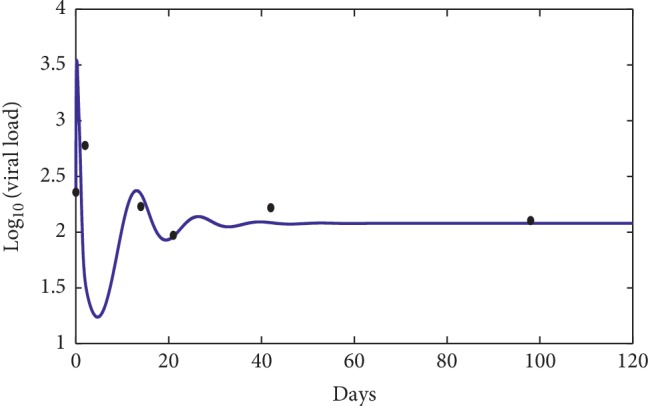
Comparison between the mathematical model (solid line) and the clinical data of the fifth patient [18] (dots). The used parameters for the model are λ=10, d1=0.0139, k1=0.05, d2=0.0495, k2=1.1, d3=0.5776, a=650, d4=0.6, q=0.5, g=10−3, h=0.12, p=0.0024, c=0.15, and b=0.5.